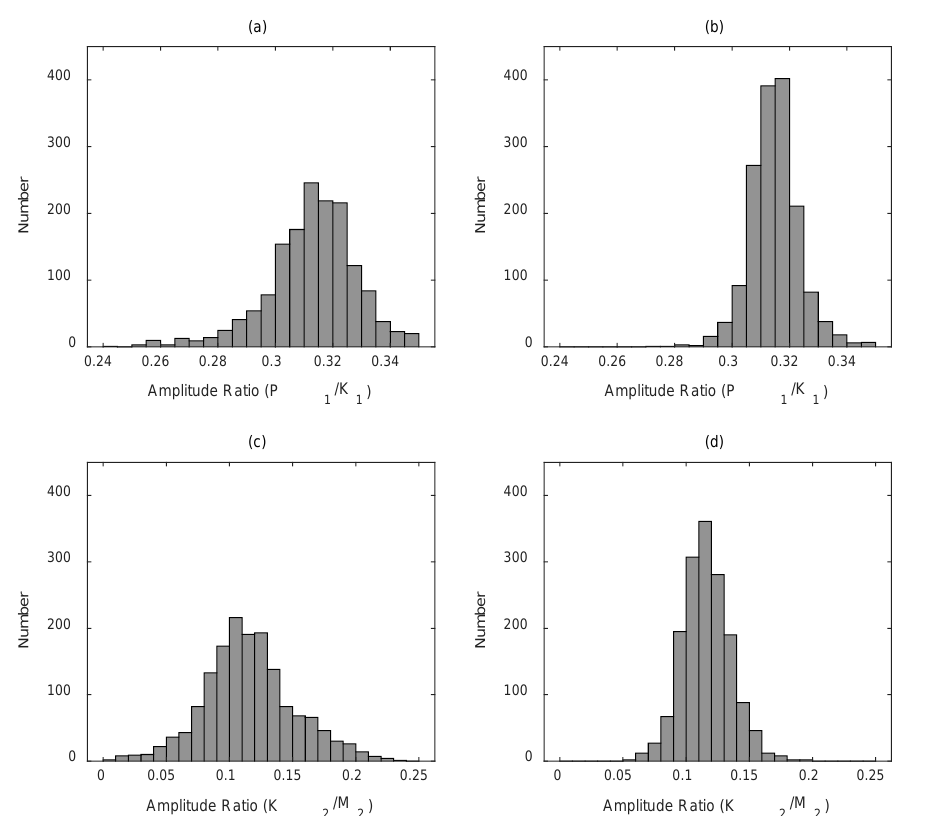
Figure 6. Histogram of the ratio of the P 1 tidal amplitude to the K 1 amplitude and the ratio of the K 2 tidal amplitude to the M 2 amplitude in the South China Sea: ( a ) P 1 / K 1 before the MVC; ( b ) P 1 / K 1 after the MVC; ( c ) K 2 / M 2 before the MVC; ( d ) K 2 / M 2 after the